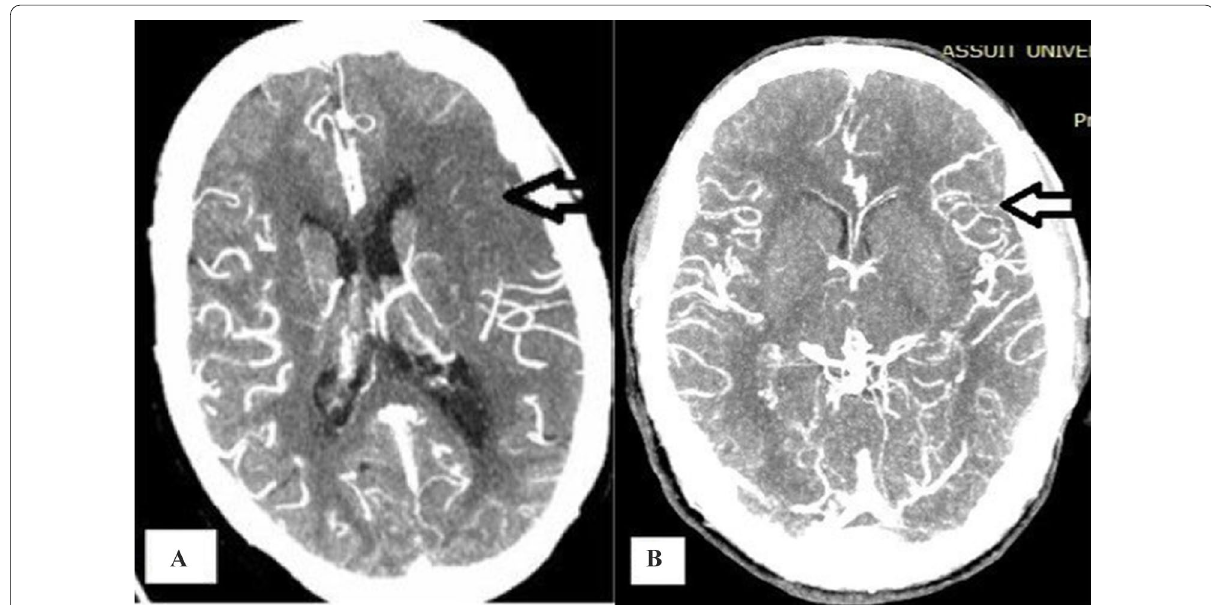
Fig. 3 Modified Tan system. A Less than 50% of the MCA territory. B More than 50% of the MCA territory